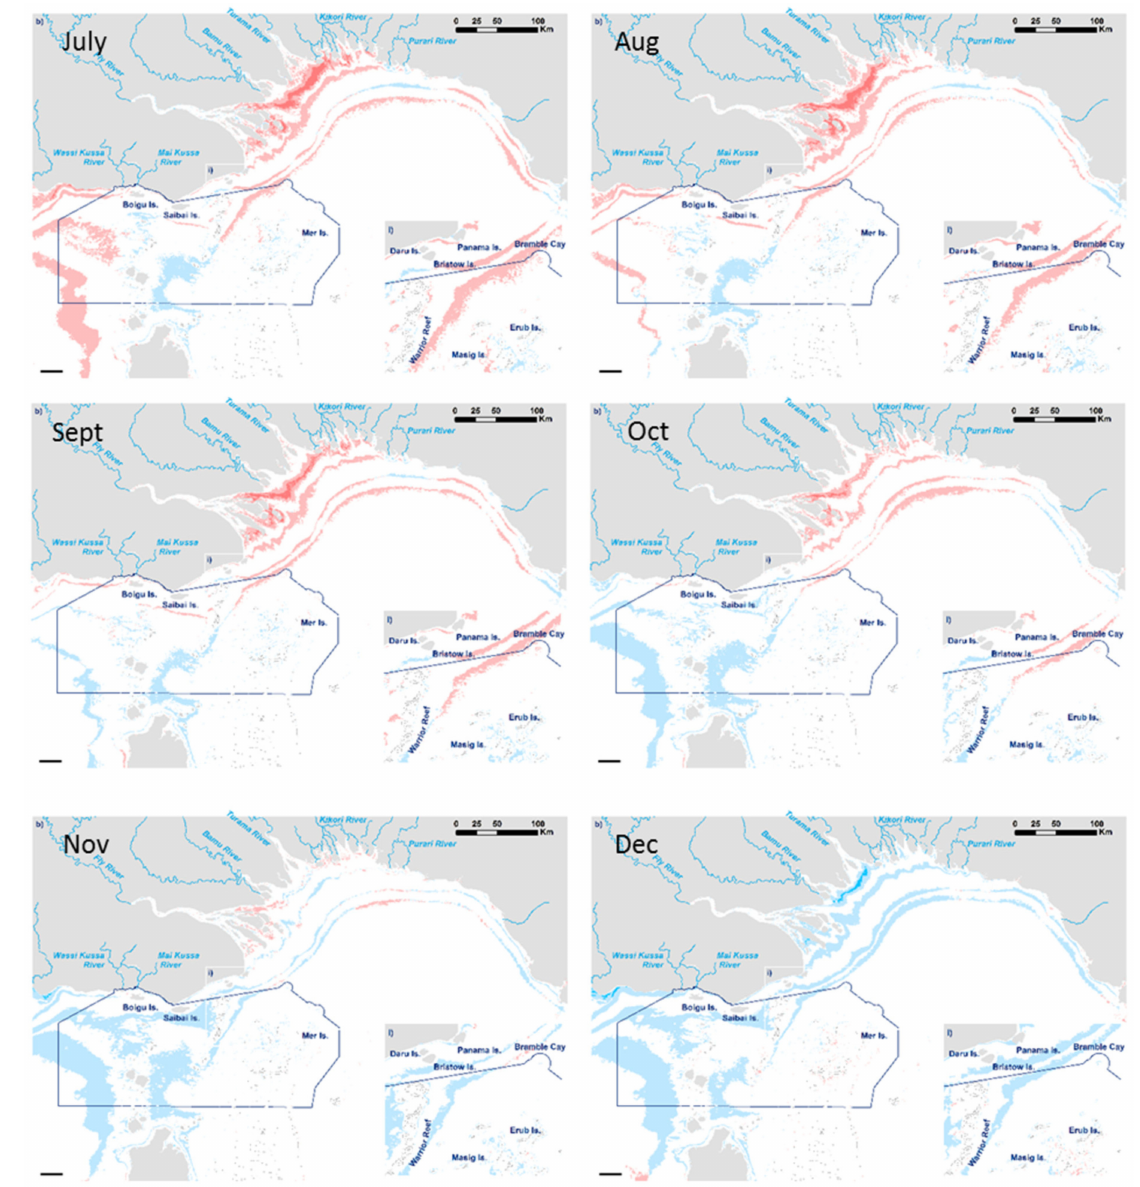
Figure A7. Decadal monthly difference maps illustrating areas with an increase (positive turbidity anomaly) or decrease (negative turbidity anomaly) in turbidity in each month relative to long-term trends: July to December. Reddish colours show areas with higher turbidity levels, blueish coloured areas have lower turbidity levels against the long-term trends. The monthly difference maps are calculated by subtracting the mean decadal monthly median maps (Table 3) and the decadal median map (Figure 4b), where an increase in colour class category means a positive turbidity anomaly (and